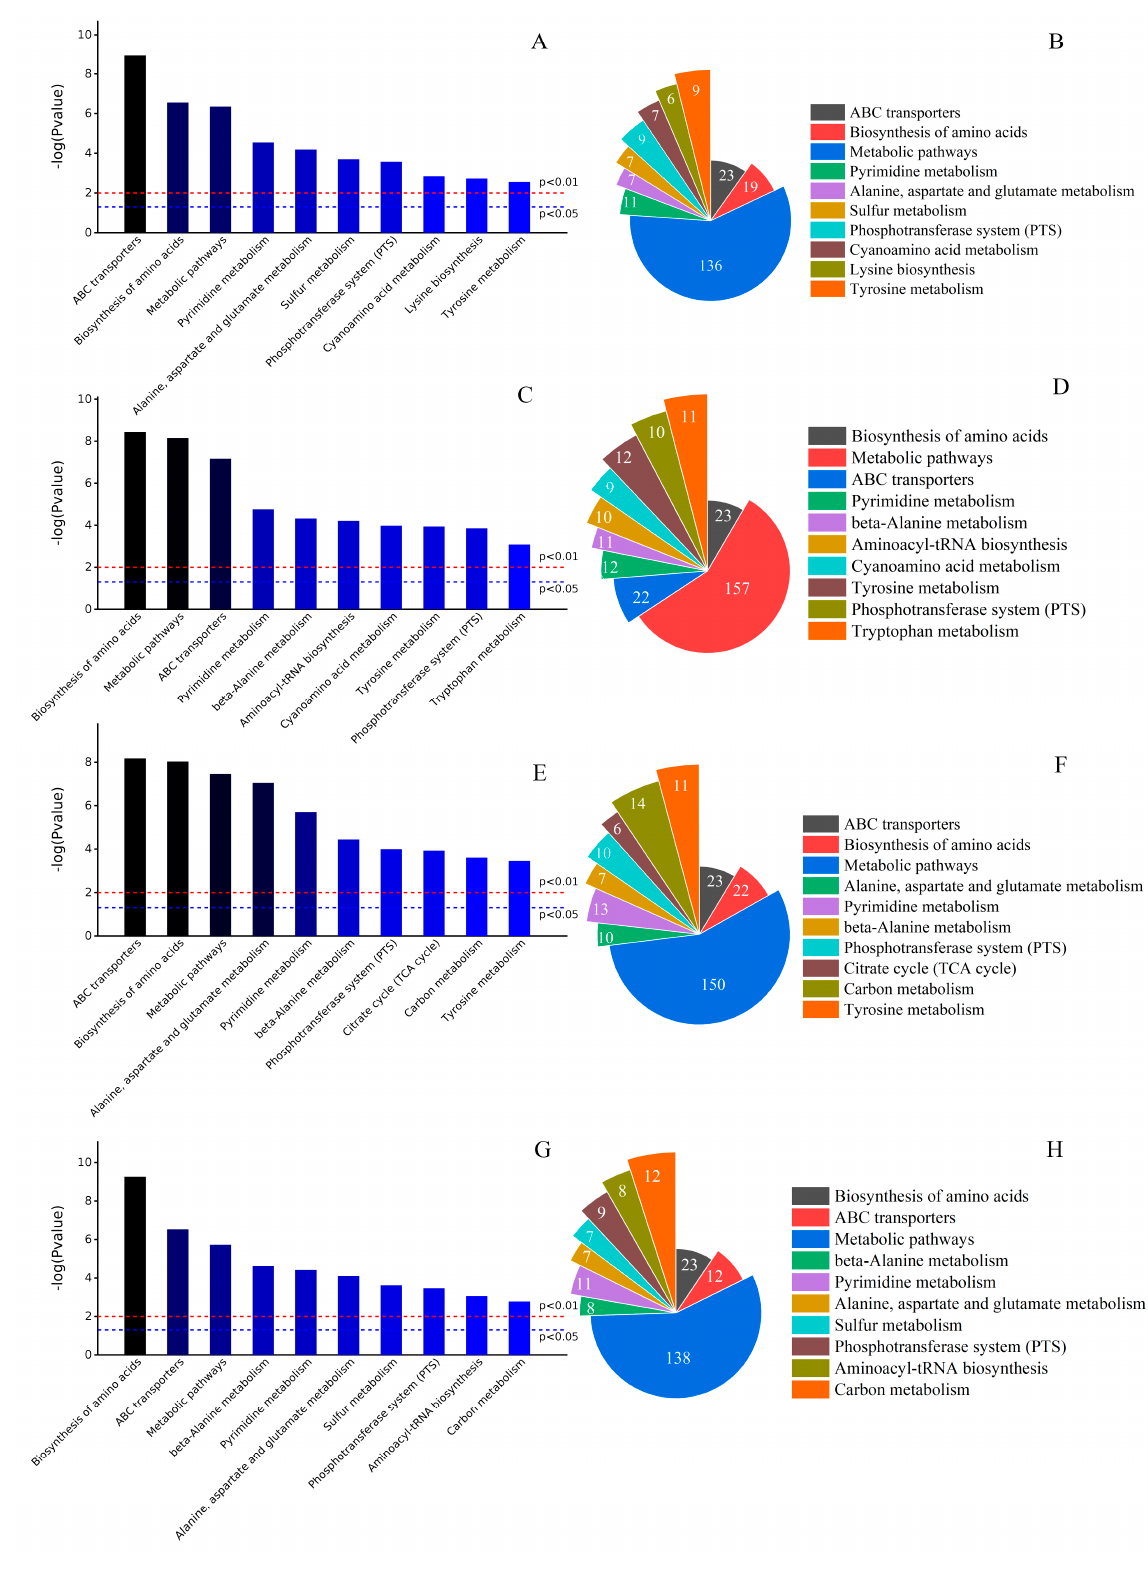
Figure 3. KEGG metabolic pathway enrichment histograms for p0 vs. p1 ( A ), p0 vs. p2 ( C ), p0 vs. p3 ( E ), and p0 vs. p4 ( G ). Top 10 metabolic pathway species for p0 vs. p1 ( B ), p0 vs. p2 ( D ), p0 vs. p3 ( F ), and p0 vs. p4 ( H ).